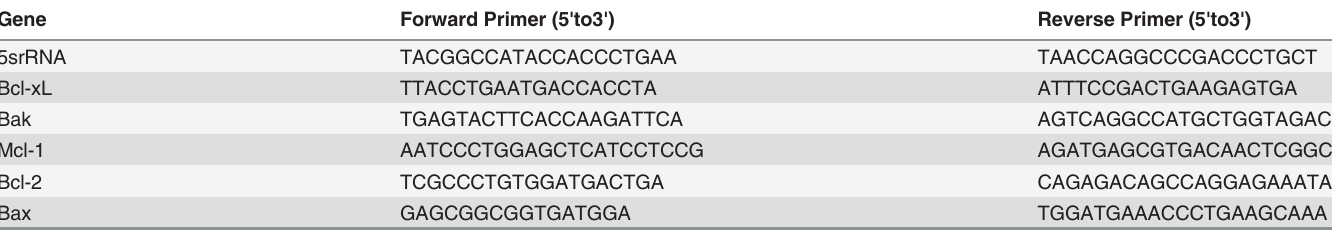
Table 1. Primers for